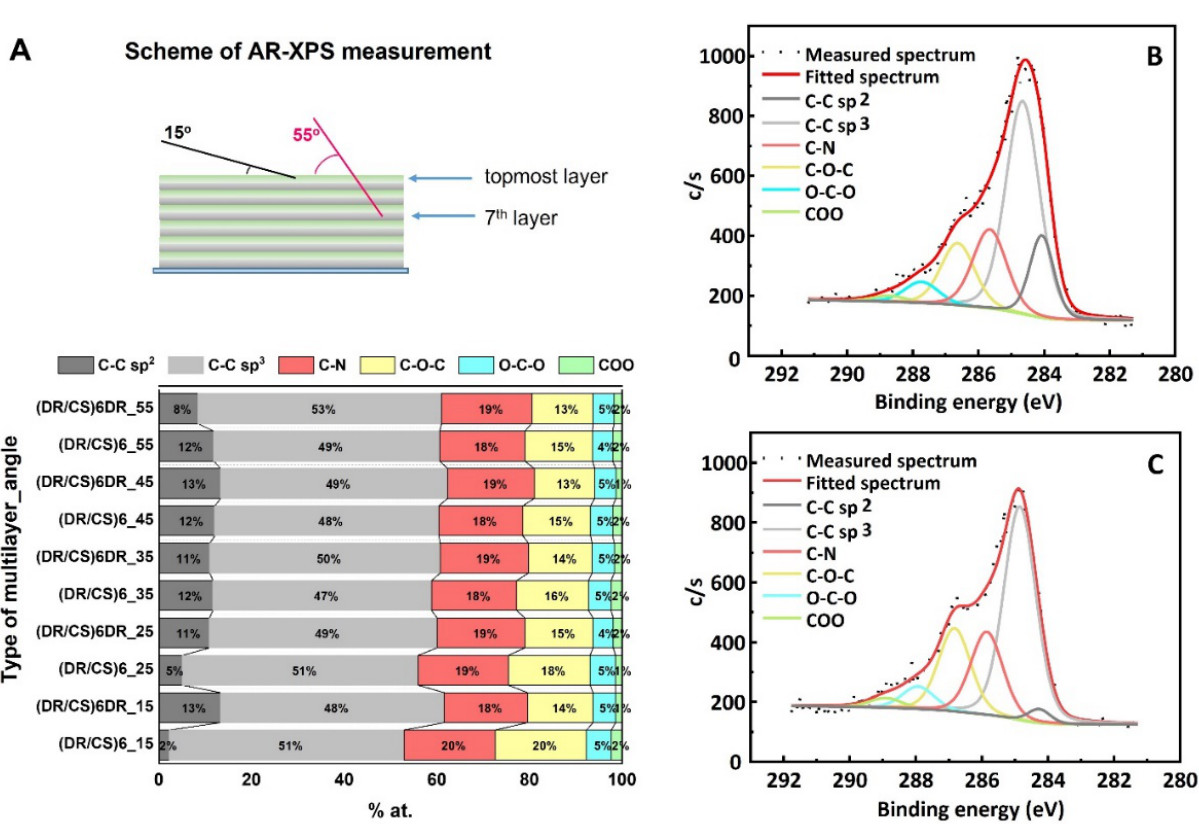
Figure 1. ( A ) Graphical representation of the angle-resolved XPS measurements. The outermost and deeper layers were analyzed at angles of 15 and 55 degrees, respectively. Data were collected using a series of sample tilt angles: 15, 25, 35, 45, and 55 degrees. Contribution of varying carbon chemical states for (DR/CS) 6 and (DR/CS) 6 DR. XPS-fitted C1s line for photocrosslinked (DR/CS) 6 ( B ) and photocrosslinked (DR/CS) 6 DR ( C ). The spectra shown were collected at a 15-degree angle.